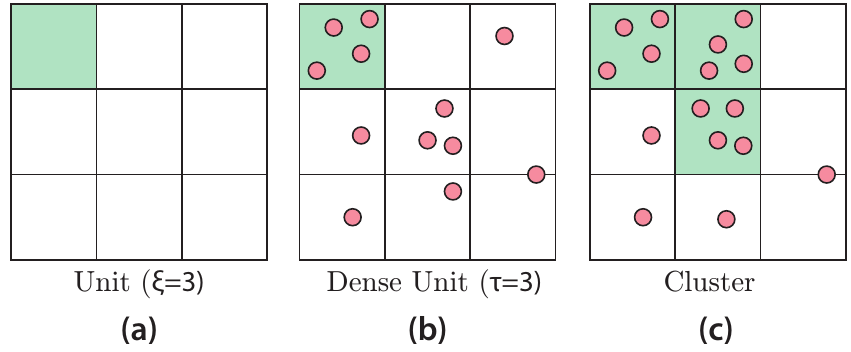
Figure 5. CLIQUE Visual Explanation. ( a ) The user defines his grid resolution and ( b , c ) use case dependent thresholds define dense units and cluster